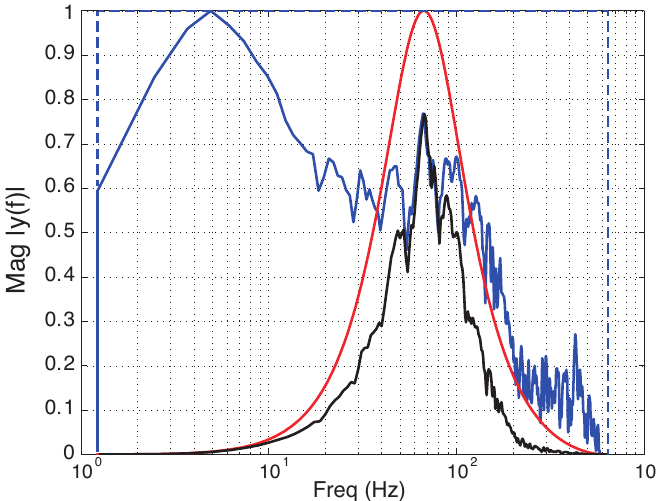
Figure 3. An example spectrum taken from an input example, weighted by the biquad coefficients, where the red line represents a peaking filter, the black line represents the biquad-filtered spectrum, and the blue line represents the spectral energy in the rectangular window ( R k